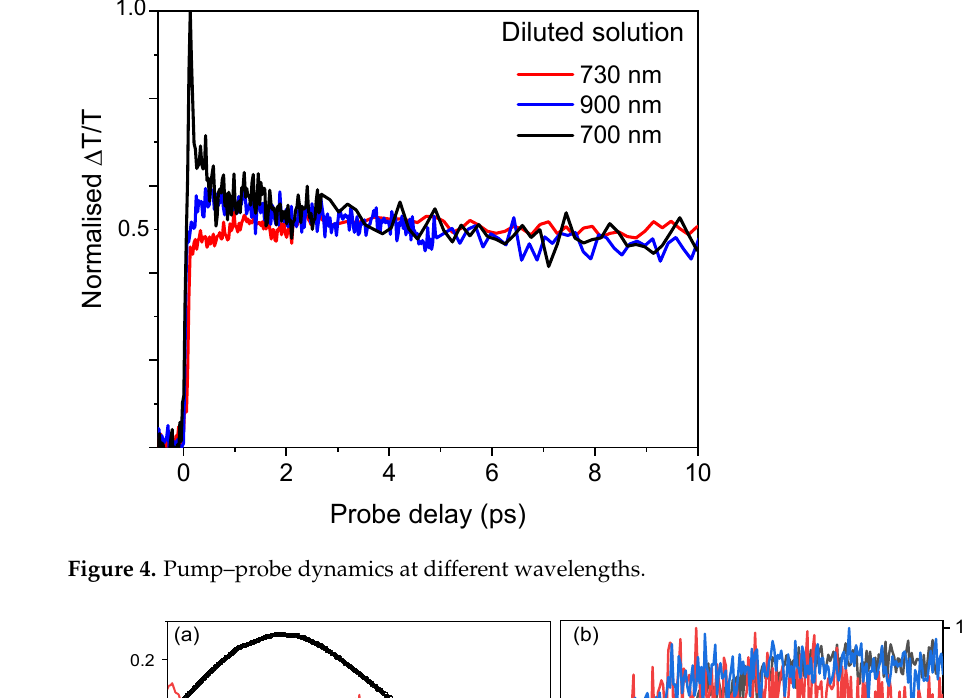
Figure 4. Pump–probe dynamics at different wavelengths.